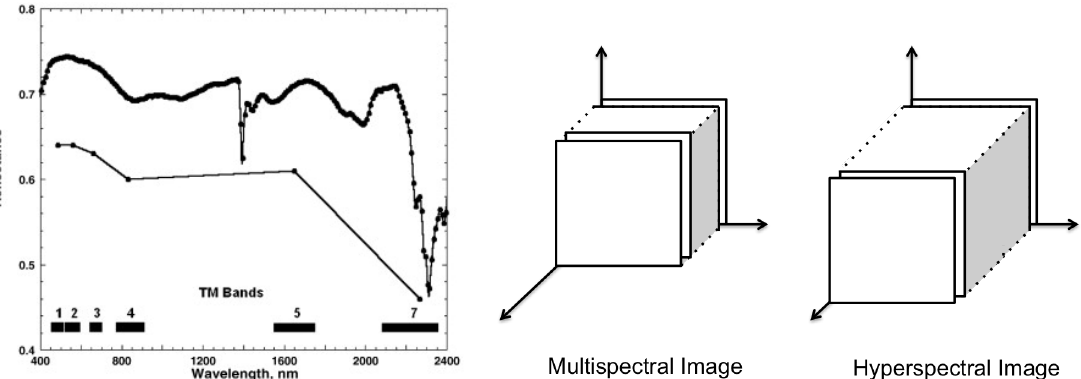
Figure 3. Left : The wavelength acquisition of spectral bands for multispectral (below) and hyperspectral sampling (above) (taken from [30]). Right : a schema of multispectral and hyperspectral images in the spatial-spectral